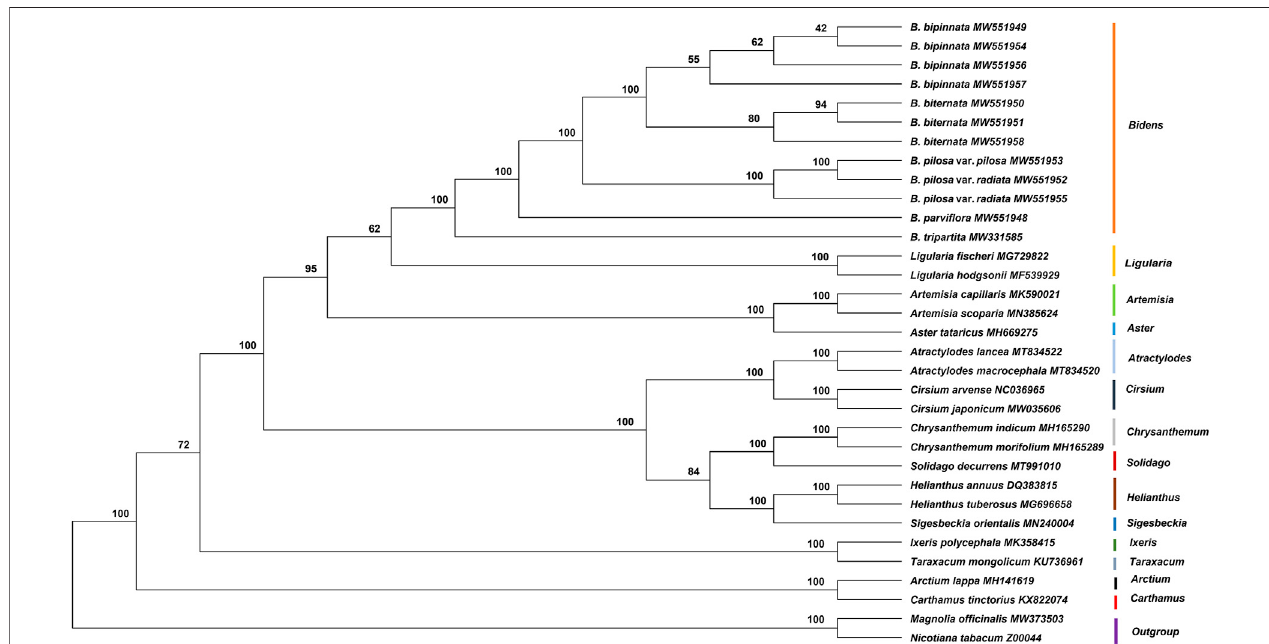
FIGURE7| PhylogenetictreeconstructedbyusingtheMLmethodbasedonthecompletechloroplastgenomesequencesofAsteraceaespecies.Thenumbersat the nodes are the values for bootstrap